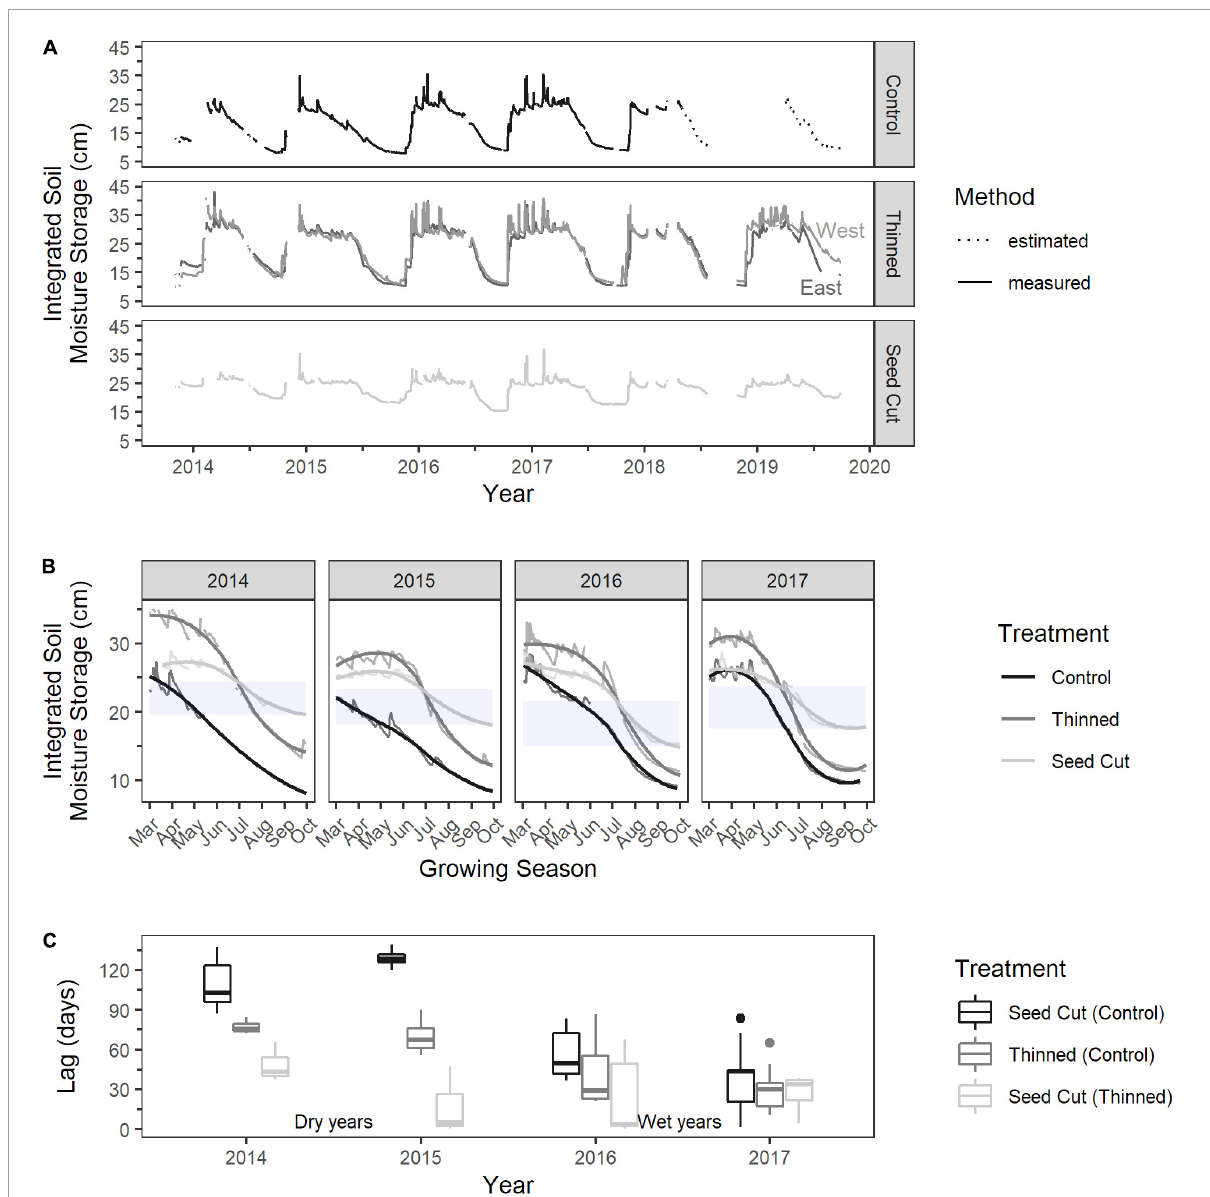
FIGURE5 (A) Integrated soil moisture storage calculated as a depth-weighted average of sensors at 30, 50, and 100 cm below ground surface in each stand. Estimated values were derived from linear regression of the 50 and 100 cm sensors. (B) Differences in soil moisture depletion during the growing season between dry (2014, 2015) and wet (2016, 2017) water years. Data are the same as in A, but overlain with a LOESS locally weighted smoothing function. Shaded rectangles indicate the region used to calculate lag in (C) . (C) Lag time in days of the treatment to achieve the same moisture values as (Control) or (Thinned). Here, “same” is defined as the nearest 0.5 value in the shaded region and results in a distribution of lags, which are visualized as boxplots. Mean lag (thick horizontal bar) was used in the text to describe differences in soil